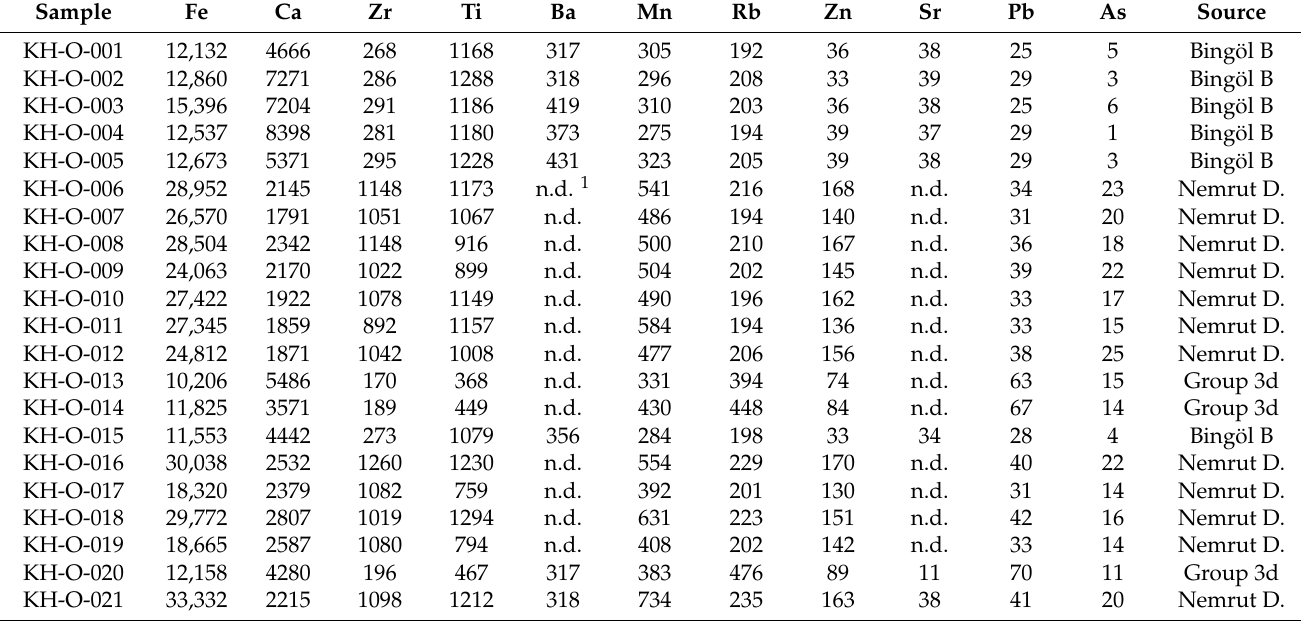
Table 3. Element composition of artefacts from Kendale Hecala obtained by